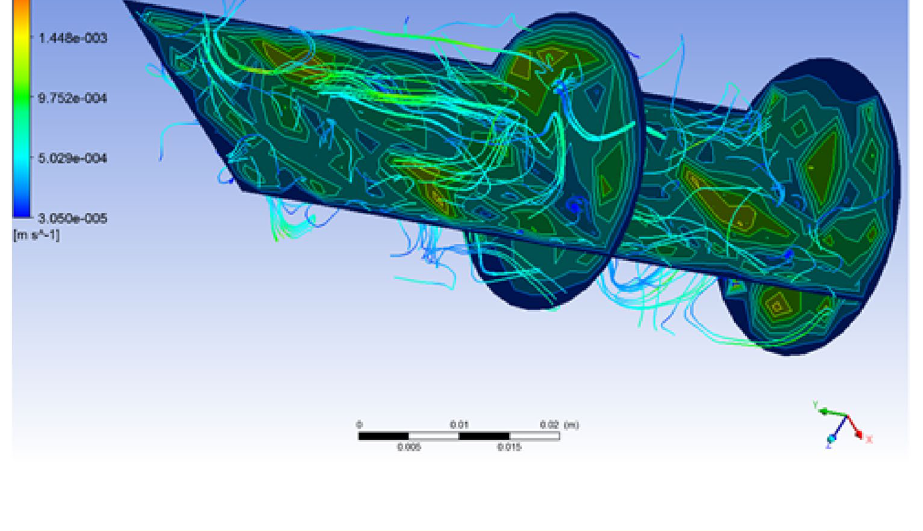
Fig. 12 Profile of flow veloci- ties across pore throats after asphaltene